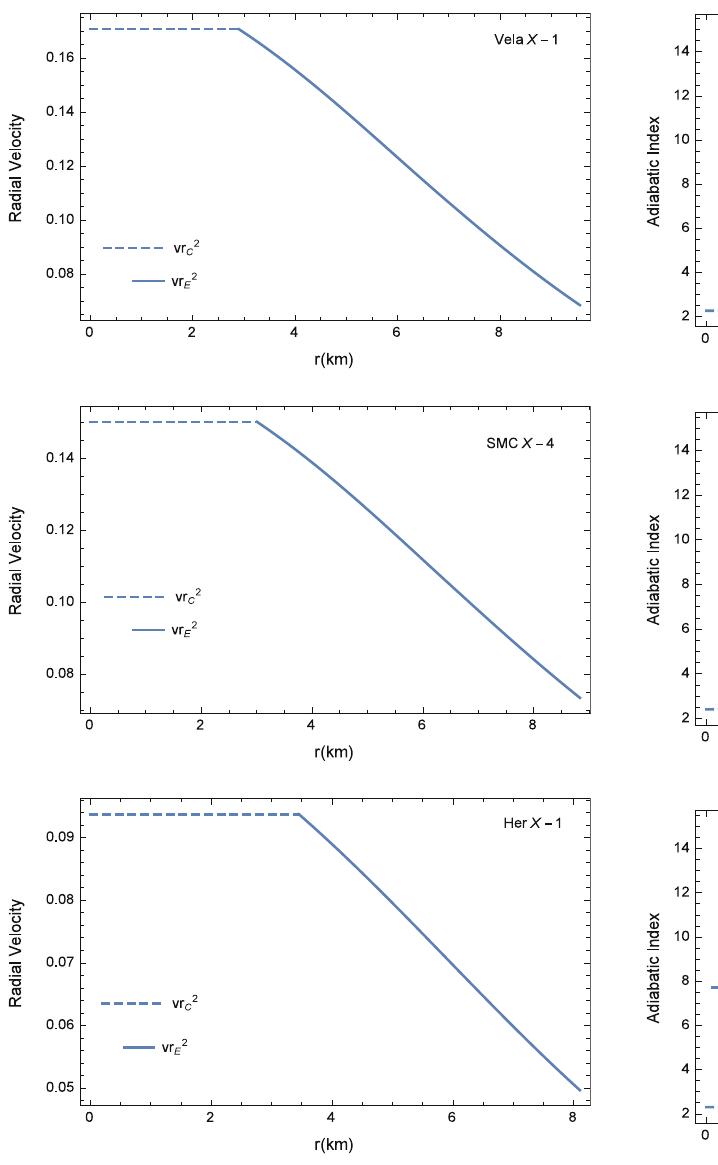
Fig. 9 Variation of radial velocity with radial coordinate r for (i) the neutron star in Vela X-1(upper) (ii) SMC X-4 (middle) (iii) Her X-1 (lower)